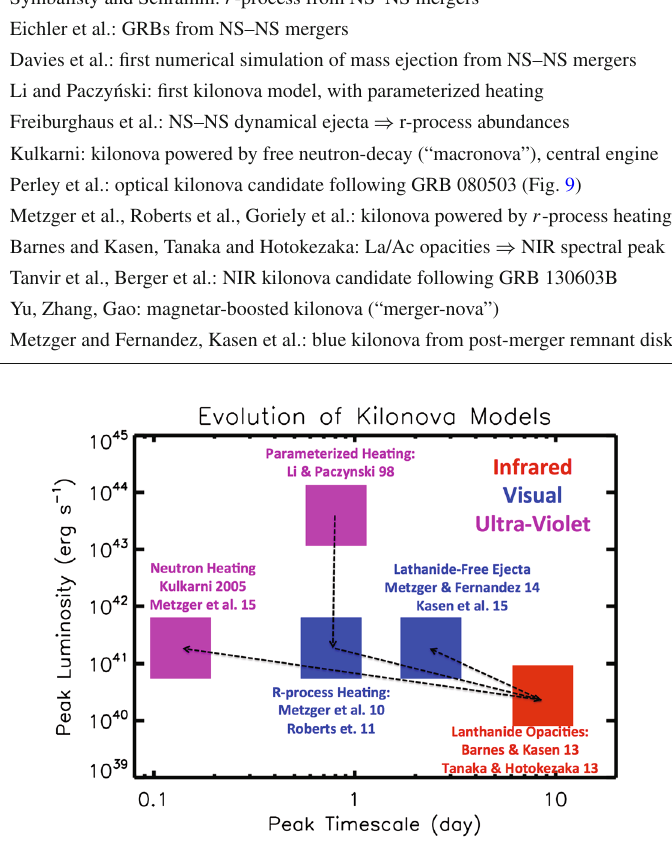
Fig. 1 Timeline of the development kilonova models in the space of peak luminosity and peak timescale. The wavelength of the predicted spectral peak are indicated by color as marked in the figure